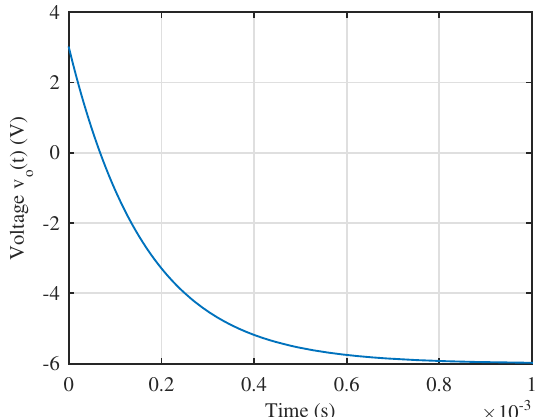
Figure 6. Transient response of the RL circuit plotted for L = 1 t = ∞ and v o = − 6 V. The voltage v o ( t ) decays exponentially from t = 0 to t = ∞ .